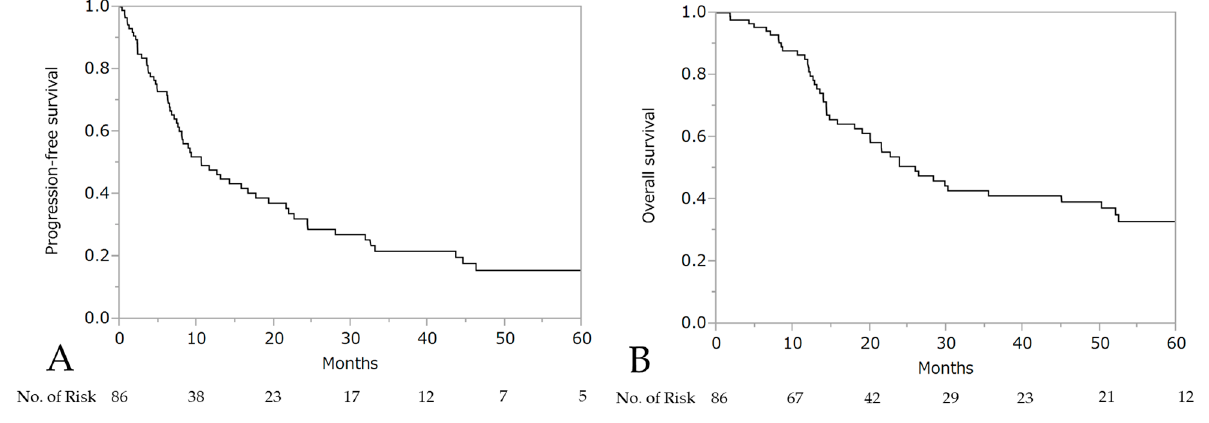
Figure 3. Progression-free survival (PFS) ( A ) and overall survival (OS) ( B ) after the initiation of wTP.